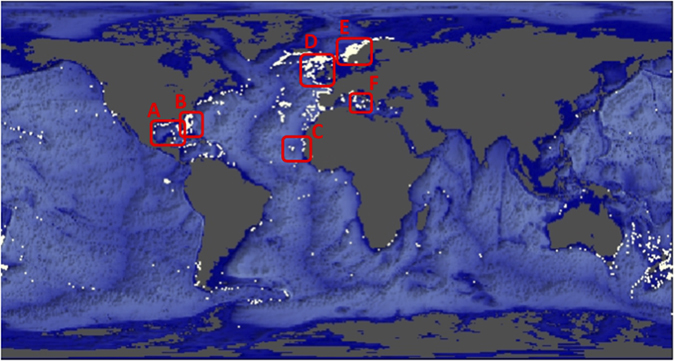
Global map with occurrences (white dots) of Scleractinian cold-water corals57 (data available at http://data.unep-wcmc.org/datasets/3).Red boxes indicate known locations along the continental shelves where Lophelia pertusa has shaped the seafloor topography into (A) a coral province of 20–40 m high in the Gulf of Mexico58, (B) coral ridges of up to 20 m high in Florida Strait59, (C) elongated mound clusters with the largest mounds reaching a height of 100 m off the coast of Mauritania60, (D) numerous and large carbonate mounds of up to 300 m high along the Irish margin16, (E) elongated CWC reefs, mostly between 10 and 15 m high, all along the Norwegian shelf331 and (F) up to 25-m high coral banks in the Mediterranean Sea61. Figure and basemap created with the R-package plot3D, version 1.1 https://cran.r-project.org/package=plot3D.